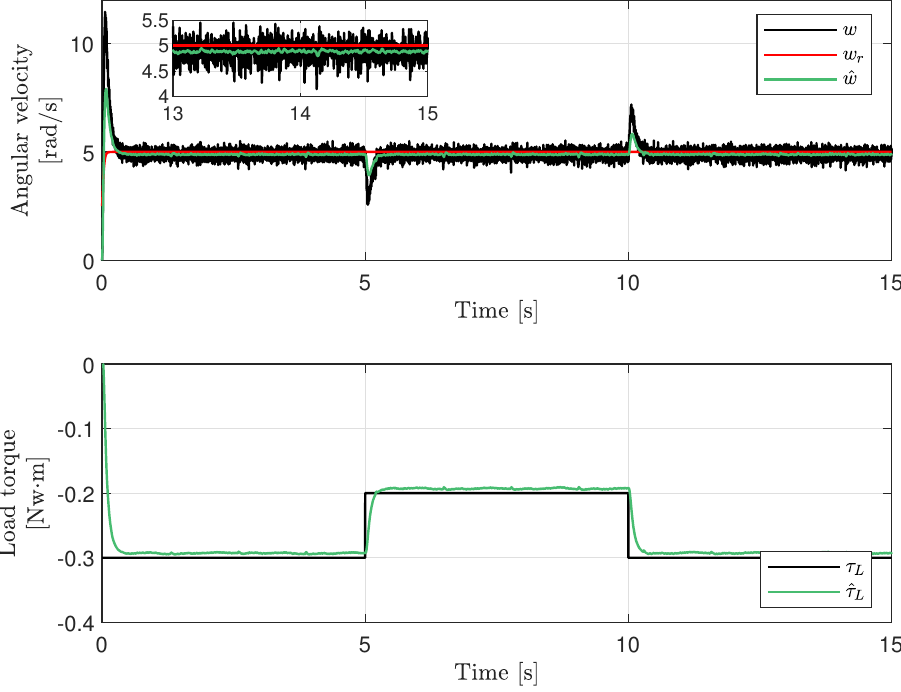
Figure 6. Variable and parameter estimations for the tracking of a trajectory implemented as a smooth